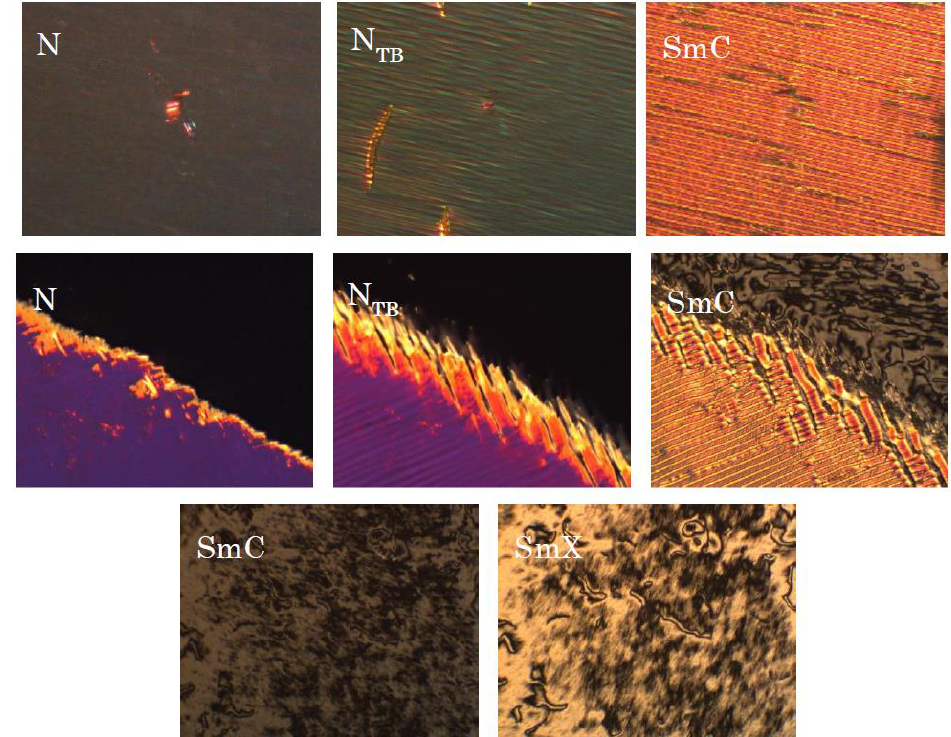
Figure 4. POM textures obtained using a planar aligned cell of 3 micron thickness for CB6OBA:4OS in the N, N TB and SmC phases (top: left to right), and using glass slides with both spontaneous planar and homeotropically aligned areas in the N, N TB , SmC, and SmX phases (middle and bottom).